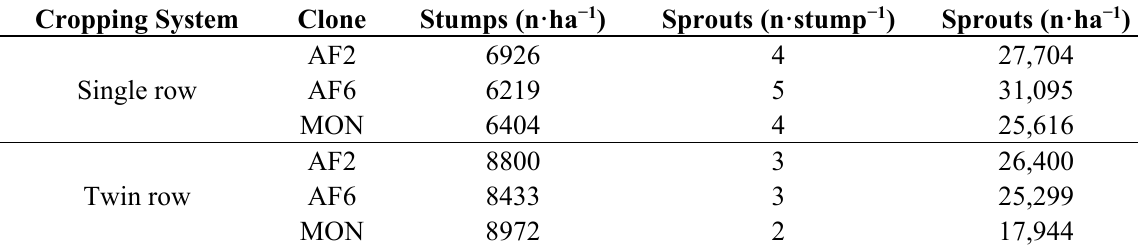
Table 2. Poplar SRC plantation characteristics.